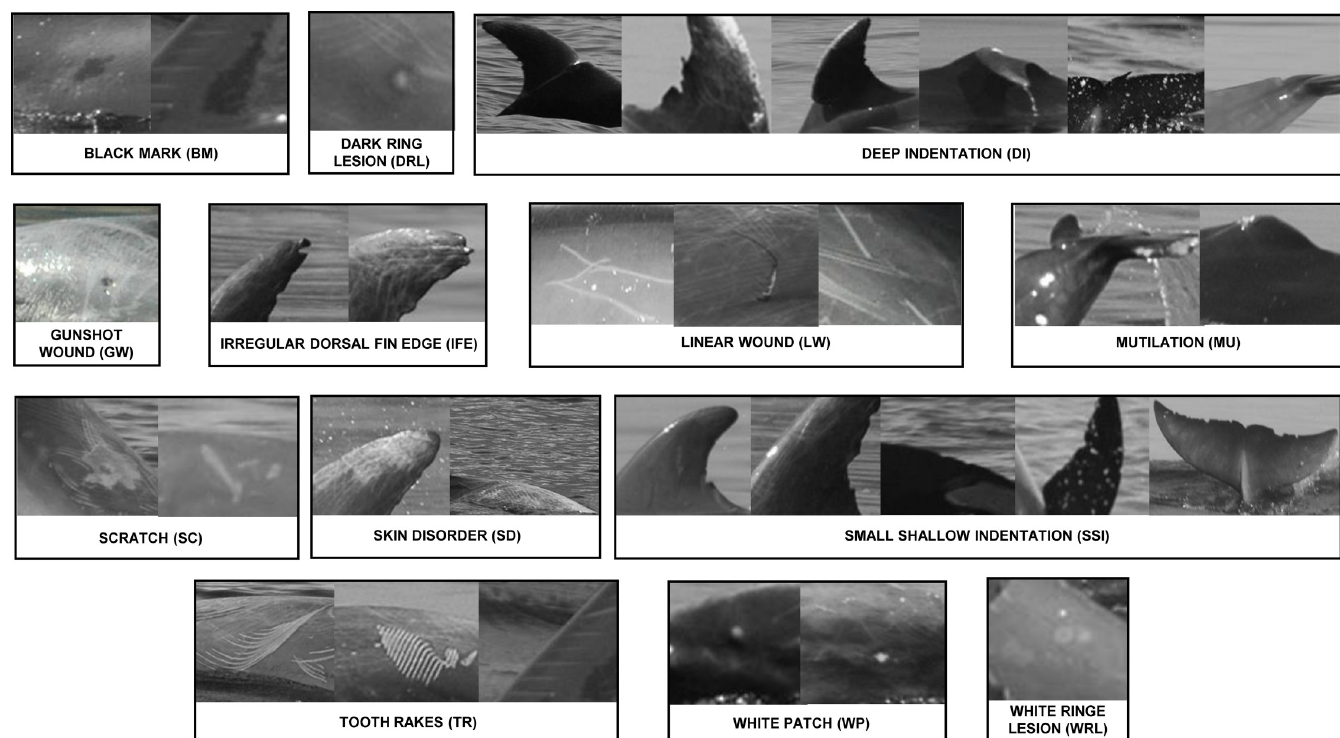
Fig 1. High-resolution photographs of the 13 skin mark types found in Aeolian bottlenose dolphins. Photographs show types of marks found on different body regions (dorsal fin, flanks, tail and flukes, back etc.) or with different degree of intensity.